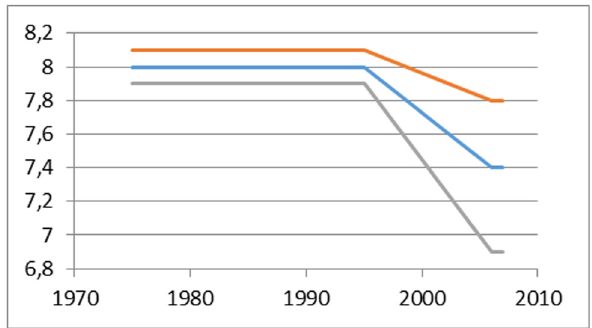
Table 6: Changes in time of statistical parameters of experimentally